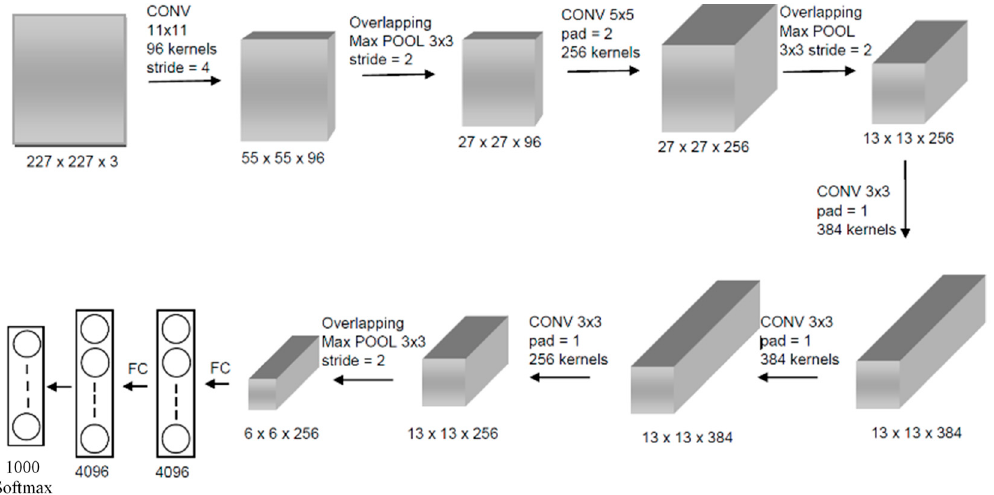
Figure 3. Illustration of the original AlexNet [45] architecture.